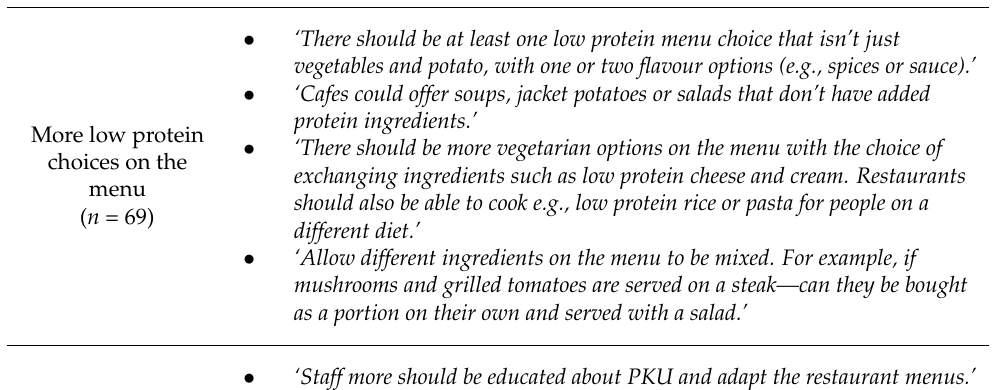
Table 6. Open ended responses to the questionnaire describing the changes that would help people with PKU dine